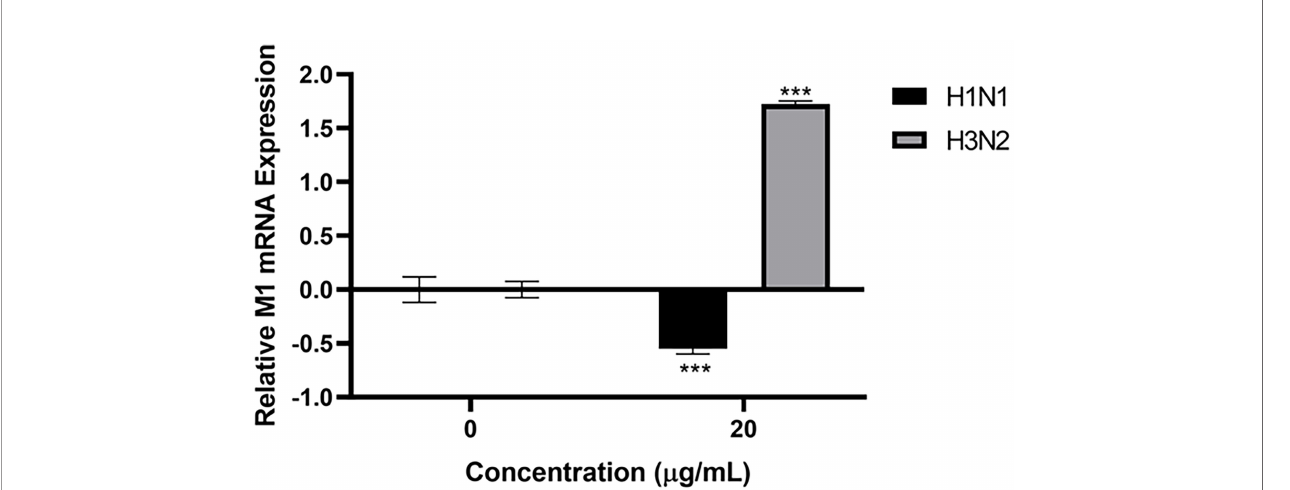
FIGURE 5 | Properdin treatment suppresses infection and replication of H1N1-infected A549 cells, while up-regulation of M1 replication was seen with H3N2. mRNA transcript levels of M1 expression of both pH1N1 and H3N2 IAV subtypes (IAV) (MOI 1) after infection of A549 cells at 6 h were measured. A549 cells were incubated with H1N1 or H3N2, pre-treated with or without human properdin (20 m g/ml). Following cell lysis, RNA was extracted and converted into cDNA. Infection was measured via qRT-PCR using M1 primers; 18S was used as an endogenous control. Data shown are normalised to M1 levels of respective untreated control (cells + virus only). Signi fi cance was determined using the two-way ANOVA test (***p < 0.001) (n = 3).